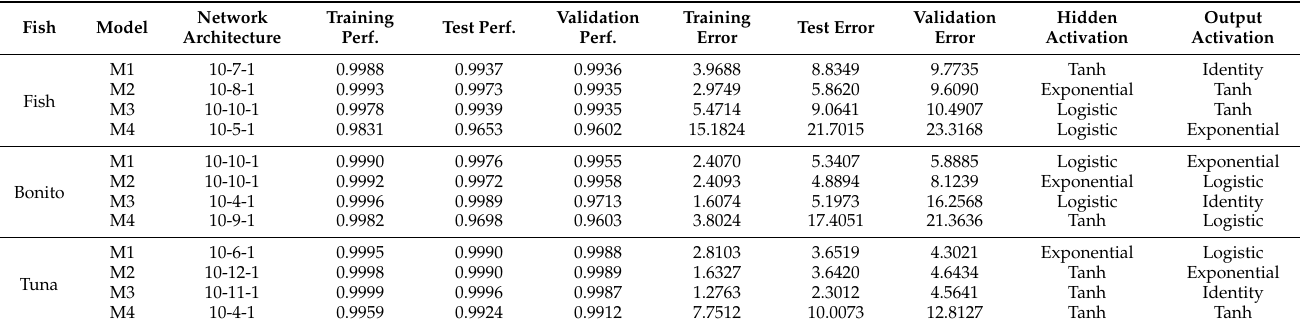
Table 6. Artificial neural network models for histamine prediction in real fish samples for combined fish samples (Fish) and individual fish species (Tuna, Bonito). Fish